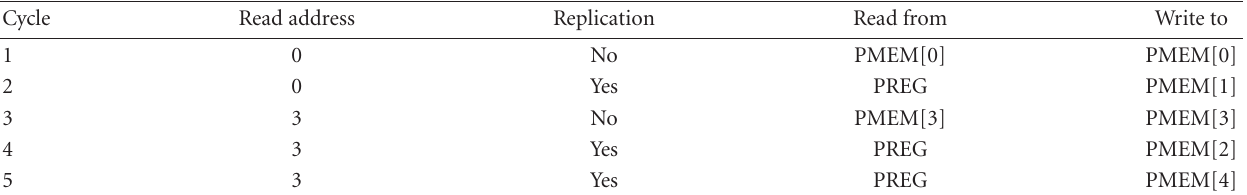
Figure 8: Addressing read and write ports of particle memory using stored indexes. (a) Contents of memory and FIFO after resampling. (b) Reading of replicated and discarded indexes. Table 1: Function of sample step. Note that writing of particles is done L S cycles after they are read, where L S is the latency of the sample